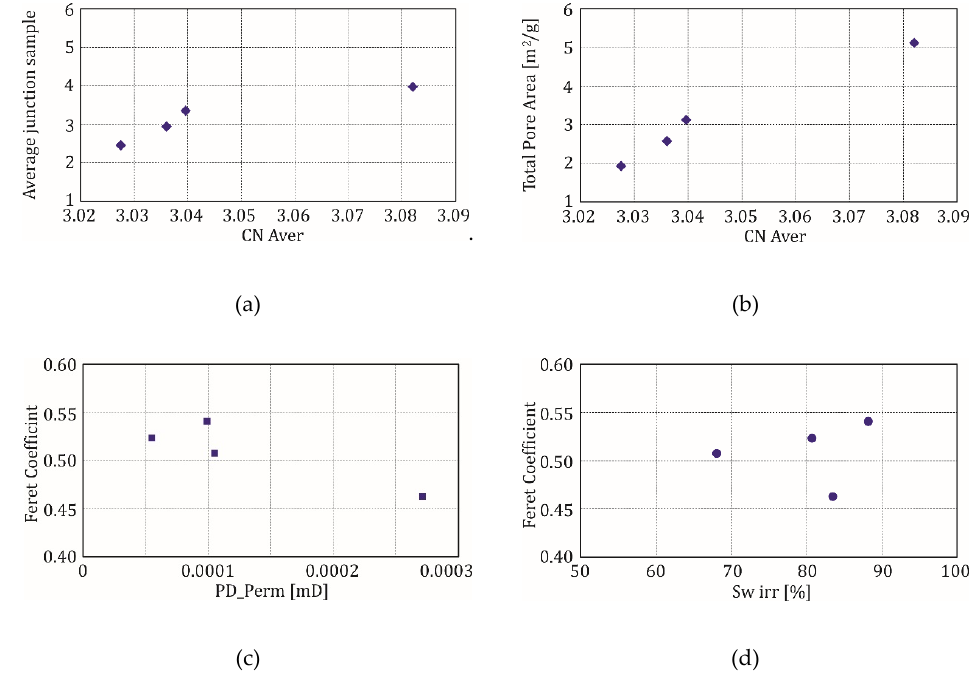
Figure 10. ( a ) Relationship between the average junction in the sample and average coordination number (CN Aver); ( b ) Relationship between TPA total pore area (MIP) and average coordination number (CN Aver); ( c ) Relationship between Feret Coefficient and pressure decay permeability (PD_Perm); ( d ) Relationship between Feret Coefficient and irreducible water saturation (Sw irr).